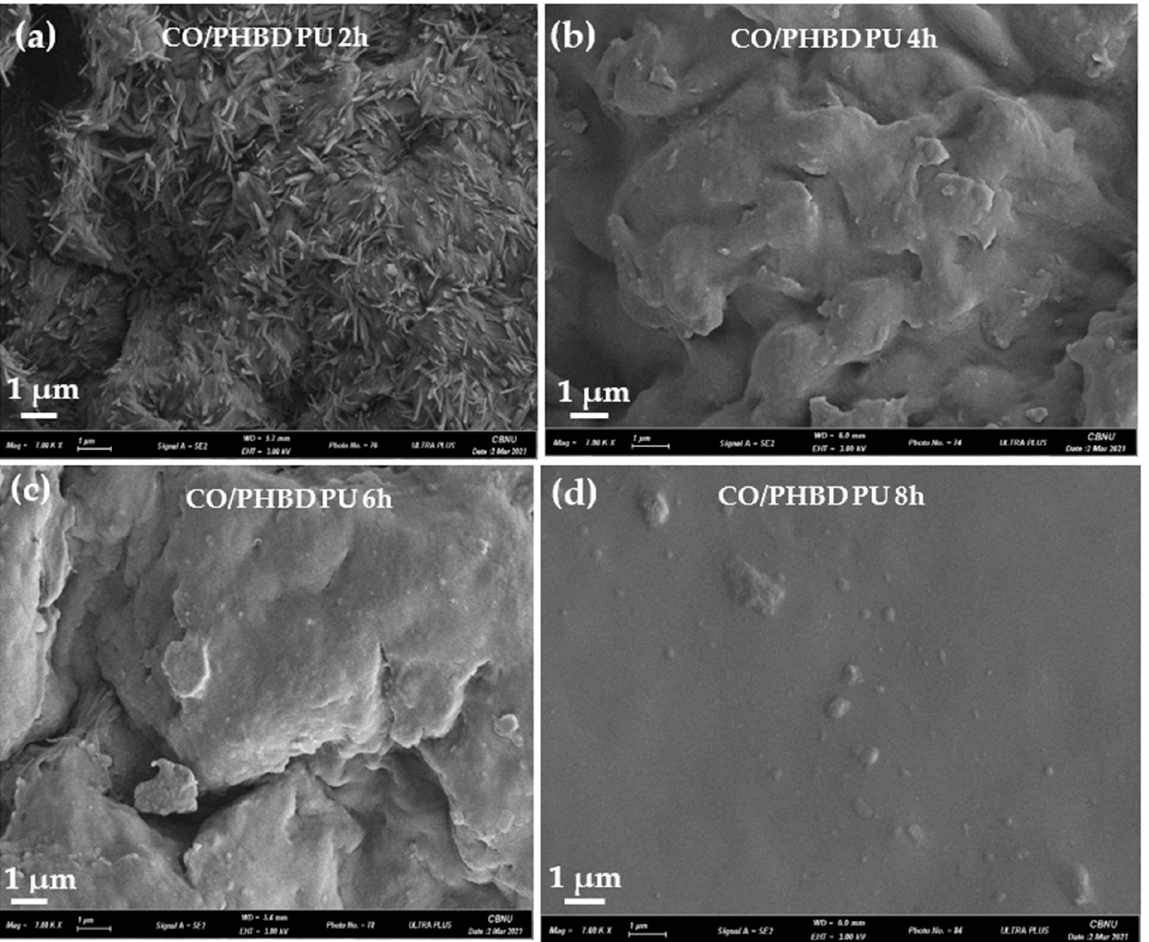
Figure 7. Morphological images of ( a ) CO-PHBD PU 2h, ( b ) CO/PHBD PU 4h, ( c ) CO/PHBD PU 6h, and ( d ) CO/PHBD PU 8h.